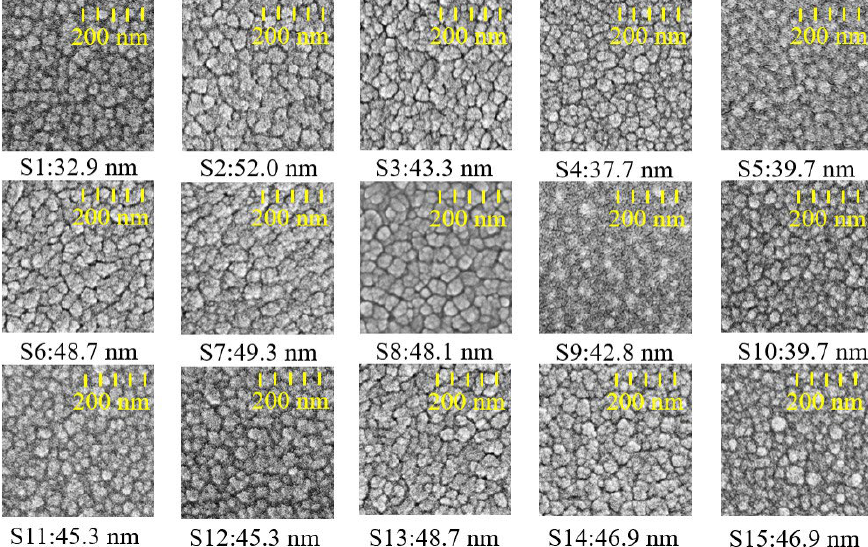
Figure 9. The top-views of SEM images on AlN films (S1–S15 in average grain size) as deposited on Si (100)